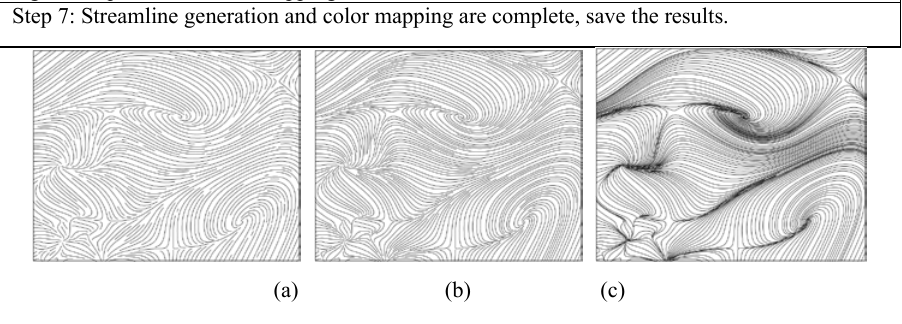
Fig. 3. Comparing the streamline diagrams changed